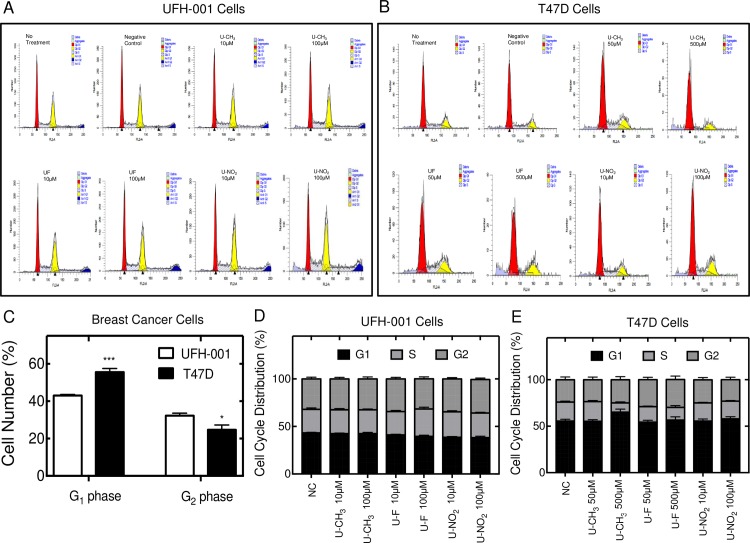
Effects of USBs on cell cycle transition in breast cancer cells.Cell cycle analysis was performed in UFH-001 (Panel A) and T47D (Panel B) cells treated with varying concentrations of USB compounds for 48 h, under normoxic conditions. Post treatment, cells were stained with propidium iodine containing RNase A. Cell cycle distribution data (gated for live, diploid cells only) was analyzed using the FCS Express Version 5 from De Novo Software from data obtained using FACS caliber. The images in A and B are representative of there repetitions and were generated by ModFit LT software. The percentage of breast cancer cells in G-phase (Panel C), all phases of the cell cycle in UFH-001 (Panel D) and T47D cells (Panel E), were quantified using Prism. Data are represented as mean of at least three independent experiments ± SEM and NC = negative control.